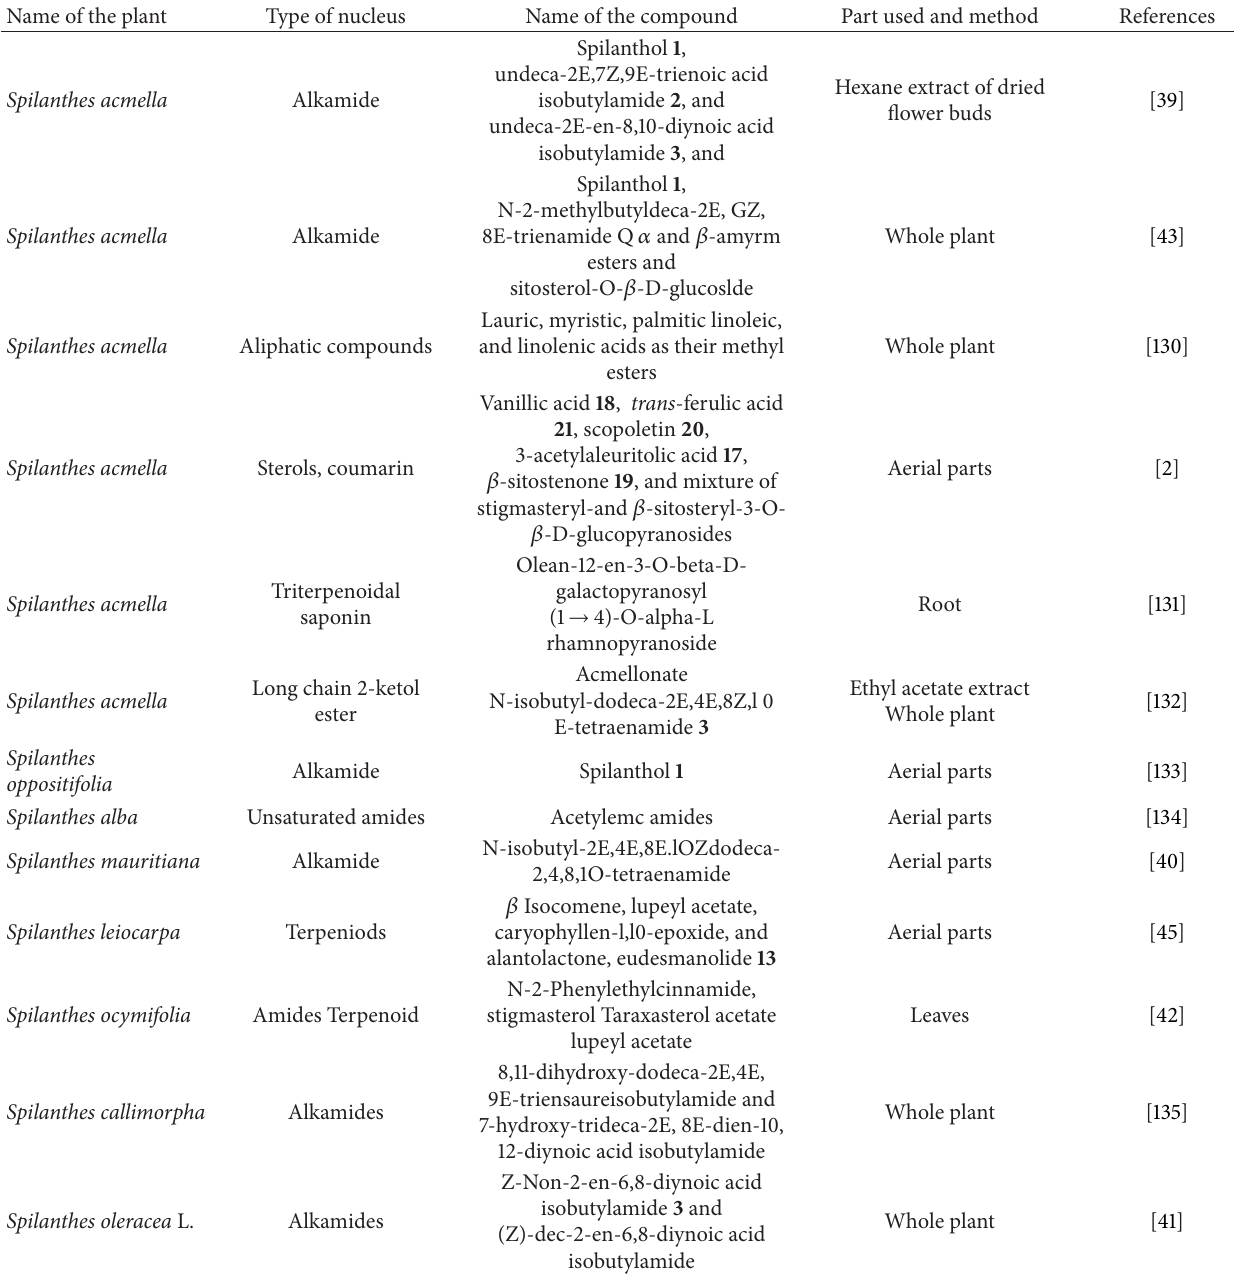
Table 2: Reported phytochemicals from genus